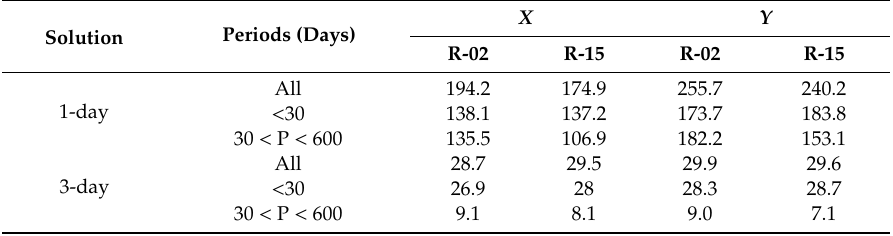
Table 2. Root-Mean-Squared (RMS) values of polar motion misclosures for the interval 2000–2014, resulting in IGS-repro02 (indicated with R-02 in the Table) and EGSIEM-REPRO (indicated with R-15 in the Table) in the x and y coordinates of the poles for the 1- and 3-day solutions, referring to different period intervals in microarcsecond ( μ as) .